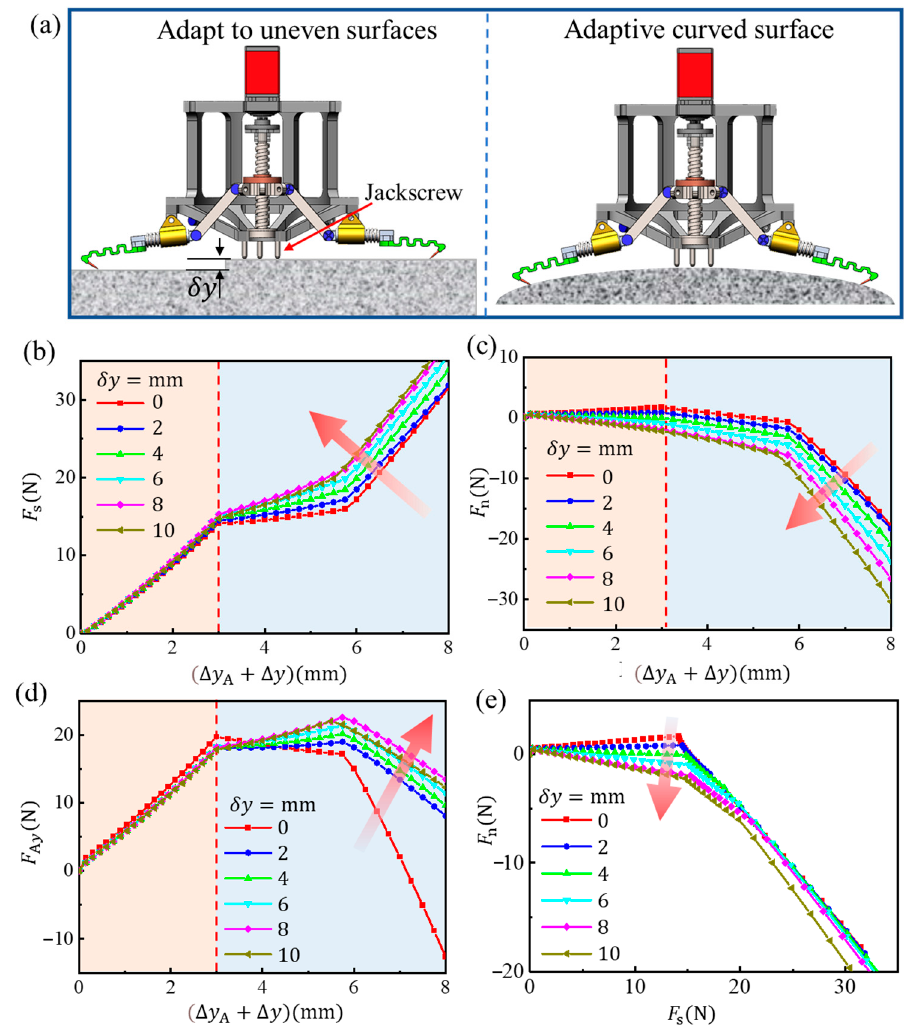
Figure 8. The microspines gripper adapts to uneven and curved surfaces. ( a ) Diagrammatic sketch. ( b ) Tangential force of needle tip. ( c ) Normal force of needle tip. ( d ) Normal force at hinge point A. ( e ) Stress diagram of needle tip in force space.